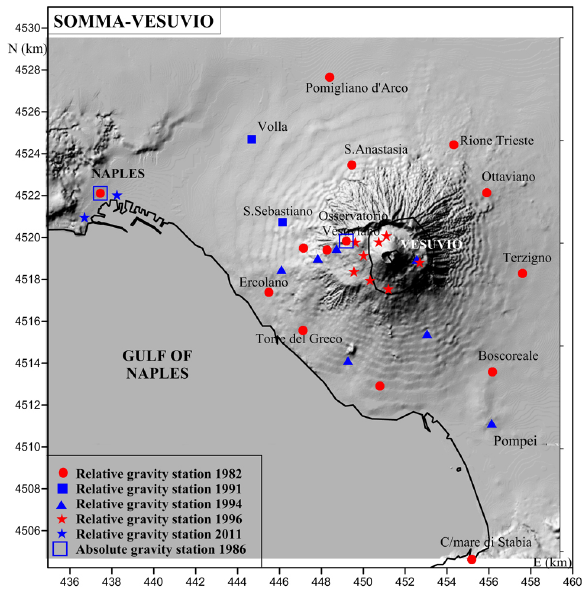
Figure 1. Gravity network at Mt. Vesuvius. Relative benchmarks are represented with several different symbols according to their es- tablishment date. The open blue squares show the location of the two absolute stations. The absolute and relative station at Osserva- torio Vesuviano (on the top of the volcano) also guests the perma- nent recording gravity station (see